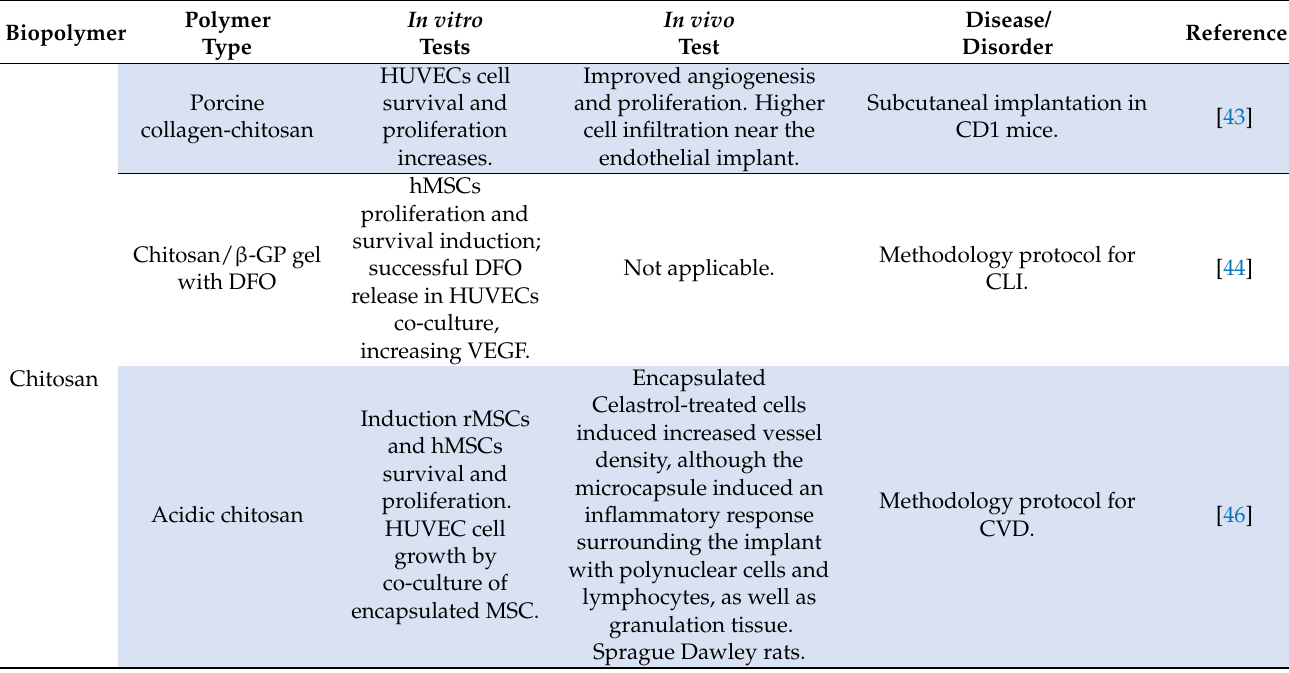
Table 1. Biopolymers currently employed in cell